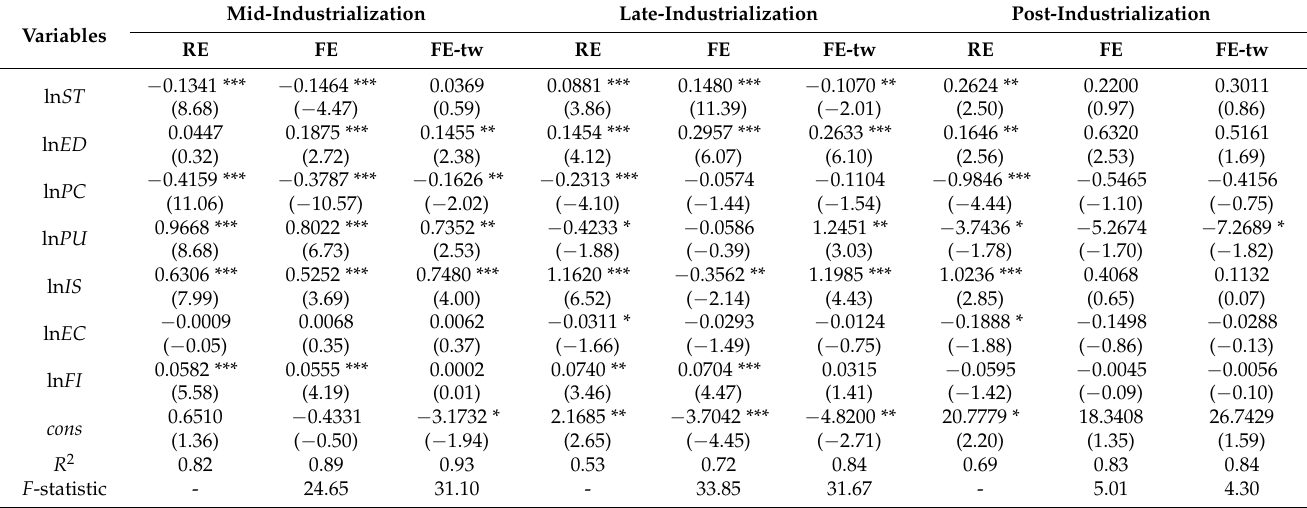
Table 7. Regression results of provincial CEE at different industrialization